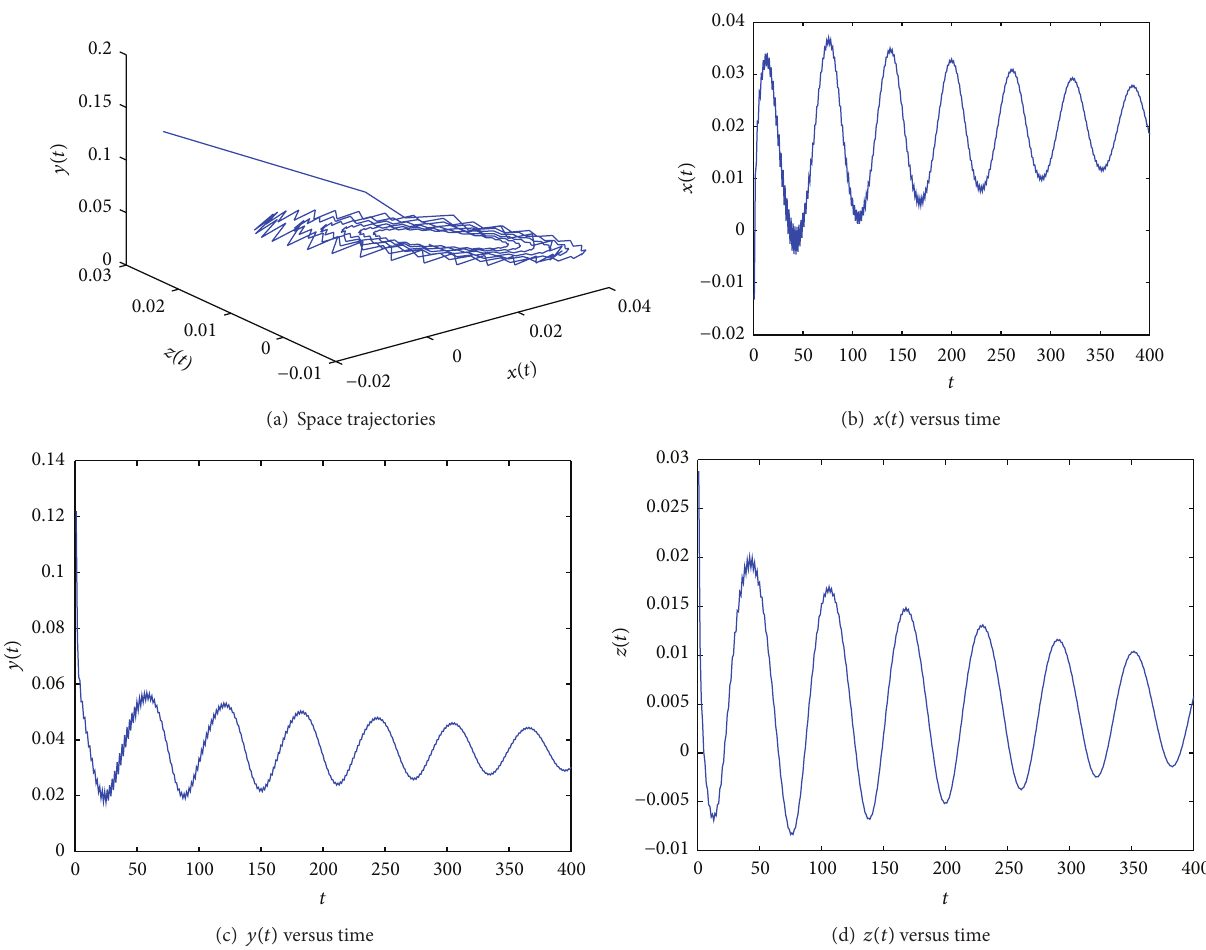
Figure 6: Space trajectory and the time responses of the estimated system about